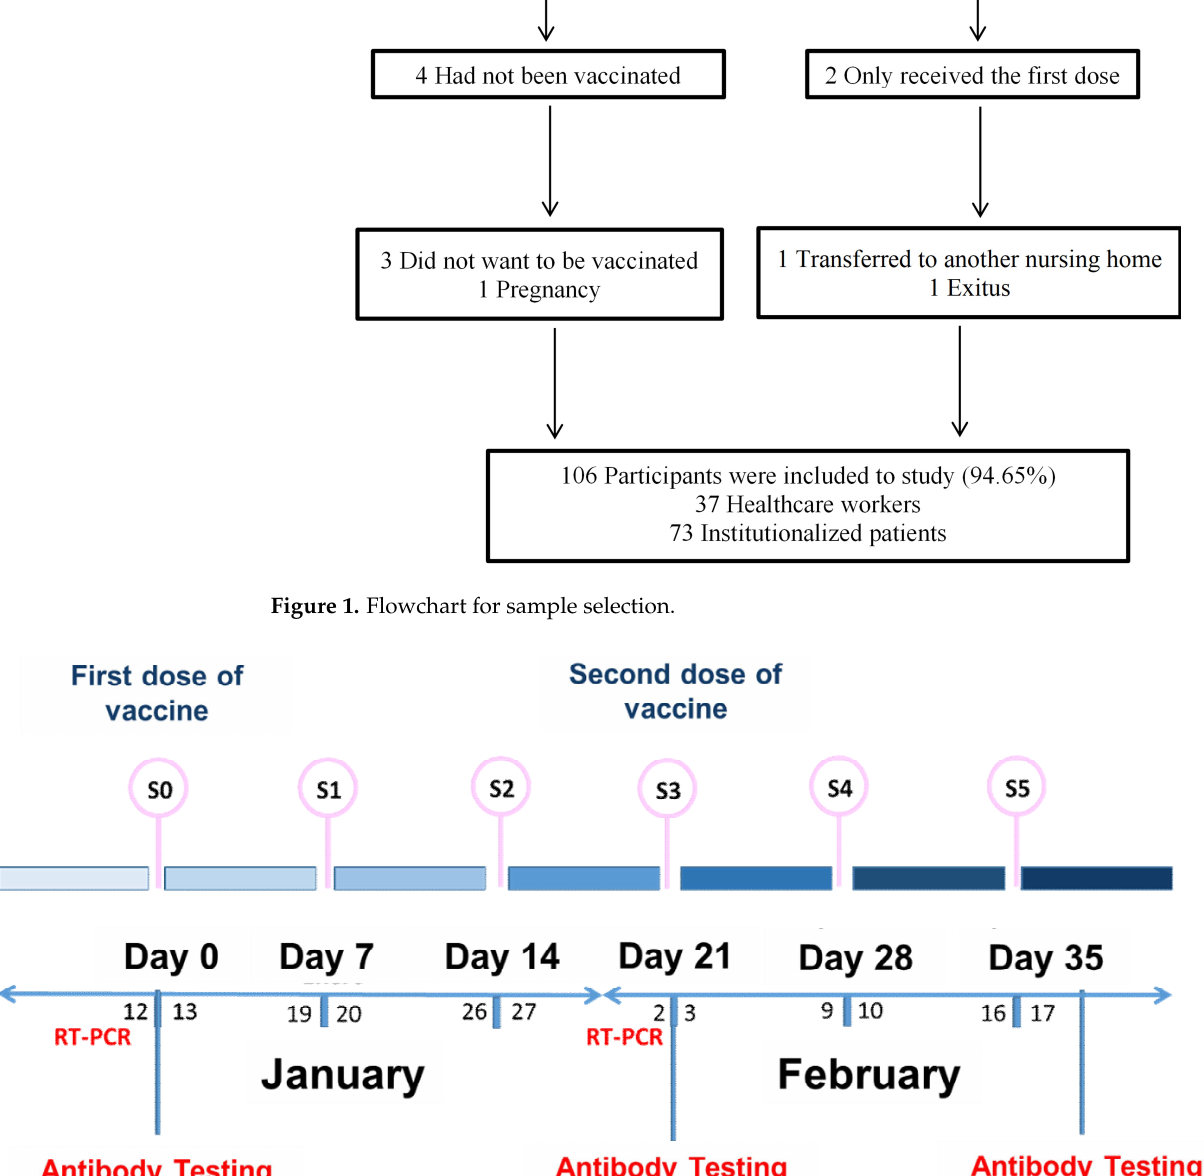
Figure 2. Timeline—Historical and current information from this a single-center prospective case series study.